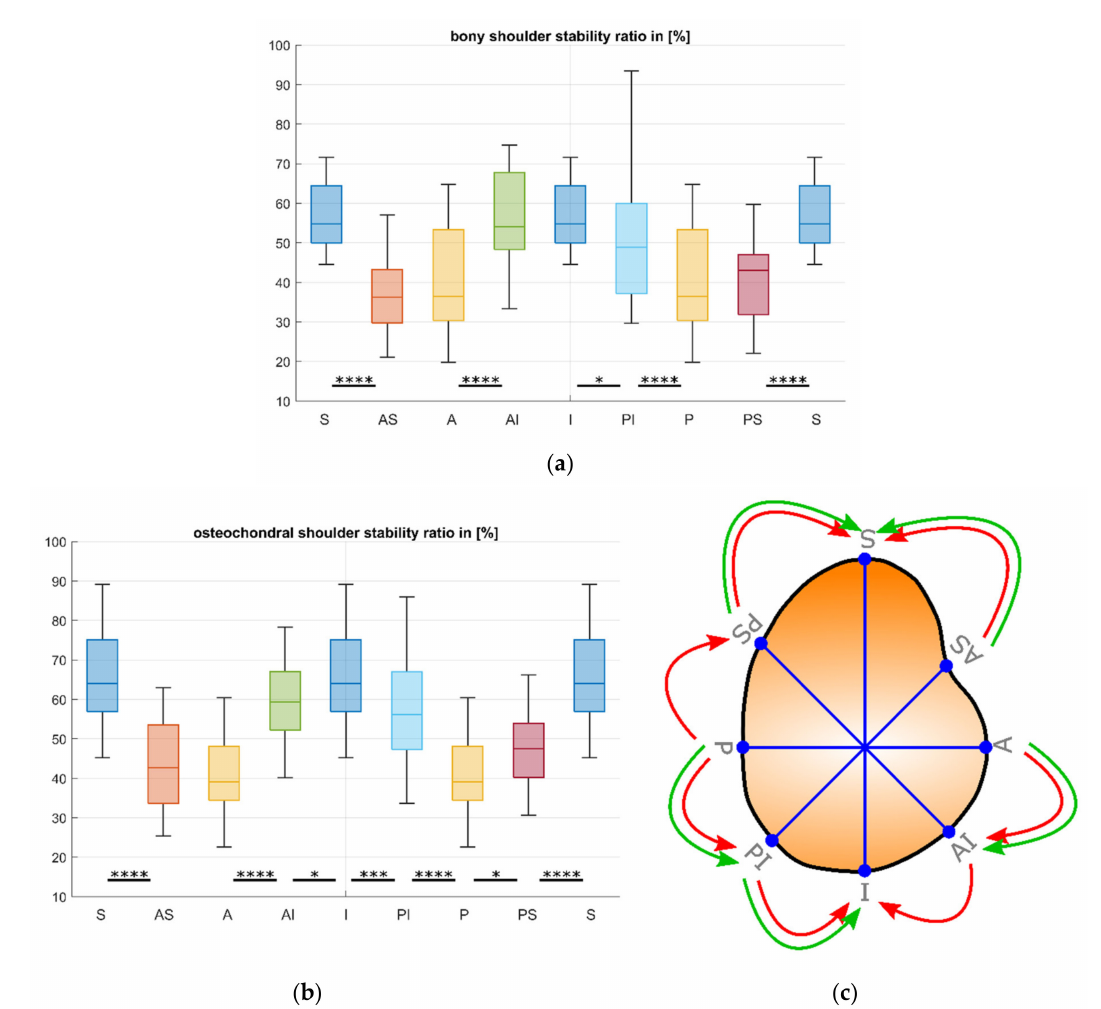
Figure 4. Distribution of concavity for the glenoid directions considered. The BSSR and OSSR increase in superior (S) and inferior (I) directions, whereas the anterior (A), posterior (P), anterosuperior (AS), and posterosuperior (PS) directions provide the least concavity. Note that values of superior and inferior as well as anterior and posterior values remain the same due to definition of the coordinate system: ( a ) BSSR; ( b ) OSSR; ( c ) schematic drawing of glenoid with arrows indicating a significant increase in BSSR (green) and OSSR (red). * p < 0.05, *** p < 0.001, **** p < 0.0001.